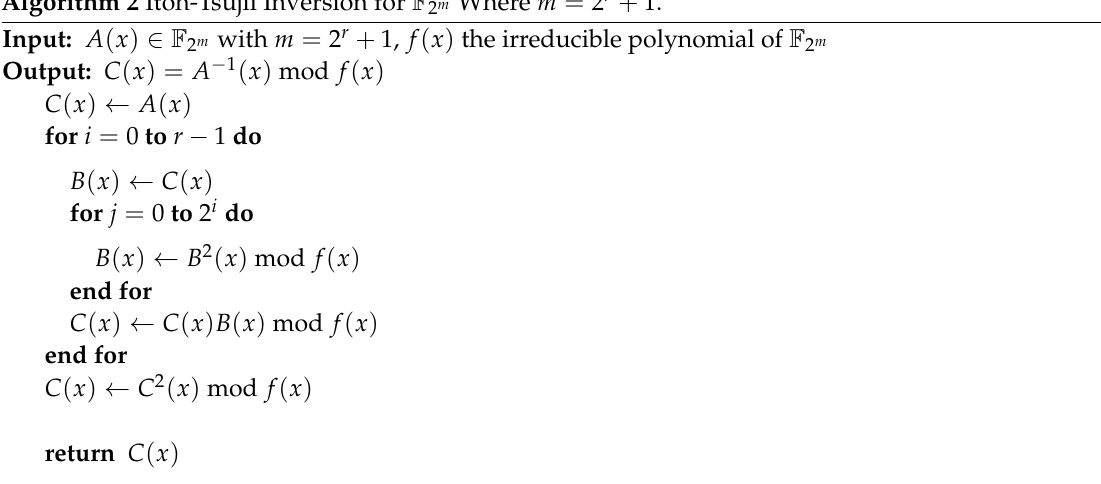
Algorithm 2 Itoh-Tsujii Inversion for F 2 m Where m = 2 r +